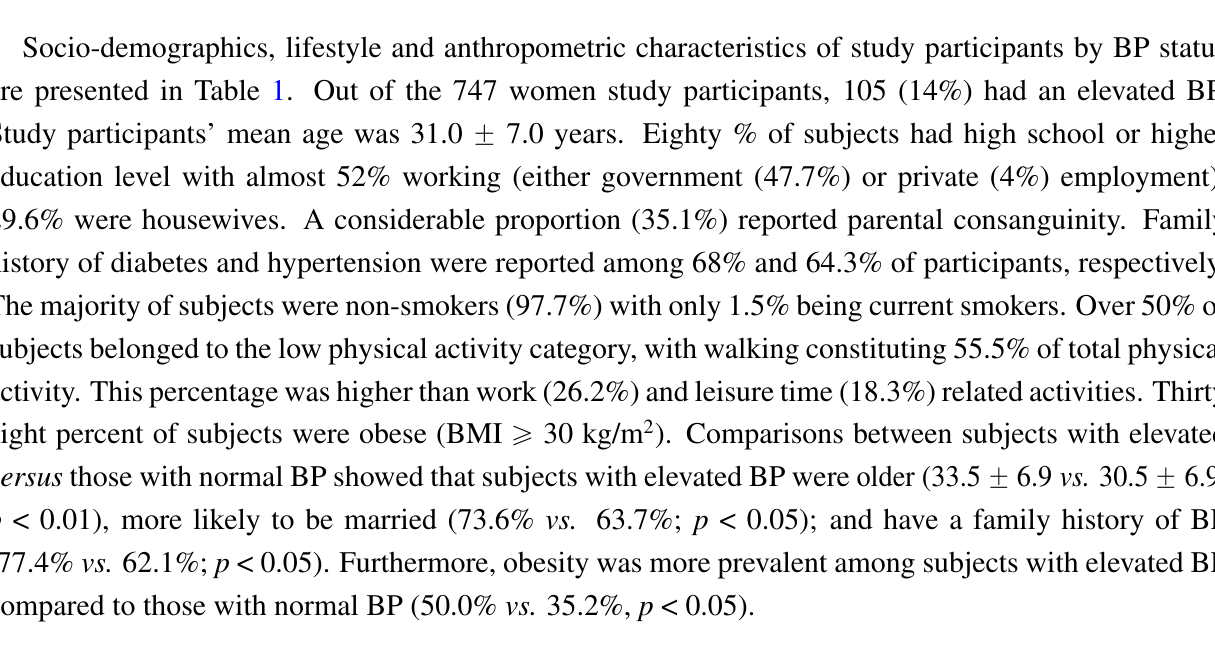
Table 1. Weighted socio-demographics, lifestyle and anthropometric characteristics of study participants by blood pressure status a ( n =